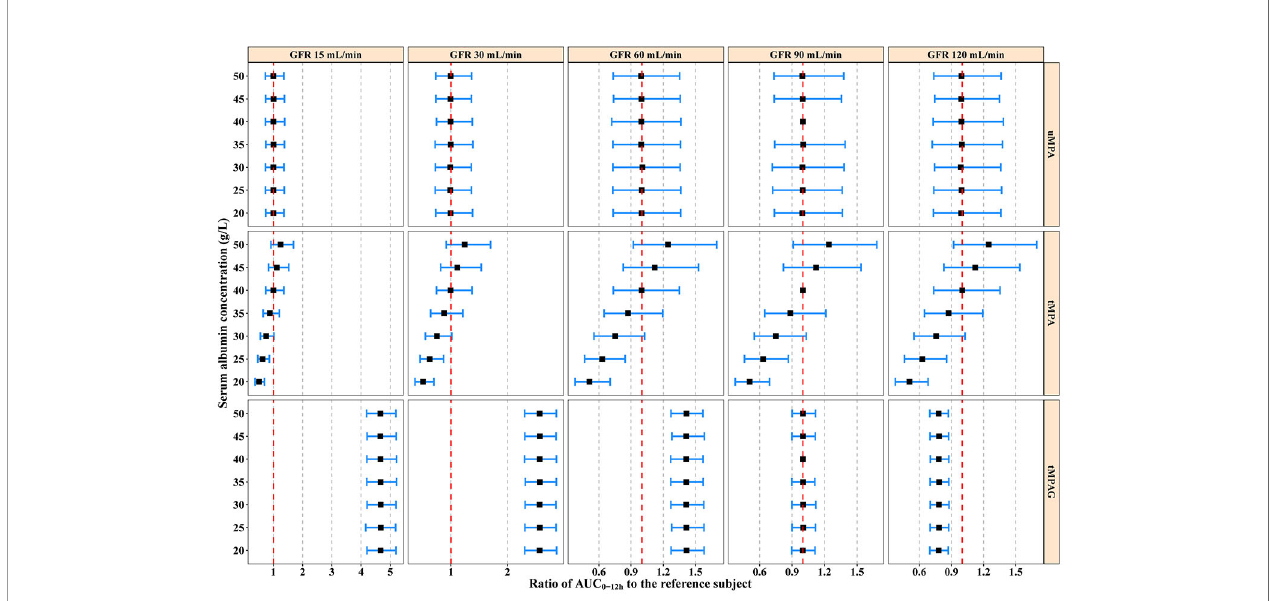
FIGURE 5 | Model-predicted covariate effects on AUC 0 – 12h of uMPA, tMPA, and tMPAG. Black squares represent median values and error bars represent 95% con fi dence intervals of the normalized exposure ratios relative to the typical reference subject (ALB 40 g/L, GFR 90 mL/min) across 2,000 simulation replicates. The vertical red dashed lines show an exposure ratio of 1 relative to the reference subject. ALB, serum albumin; AUC 0 – 12h , area under the concentration – time curve within 12-h dose-interval; GFR, glomerular fi ltration rate; tMPA, total mycophenolic acid (MPA); tMPAG, total 7-O-mycophenolic acid glucuronide; uMPA, unbound